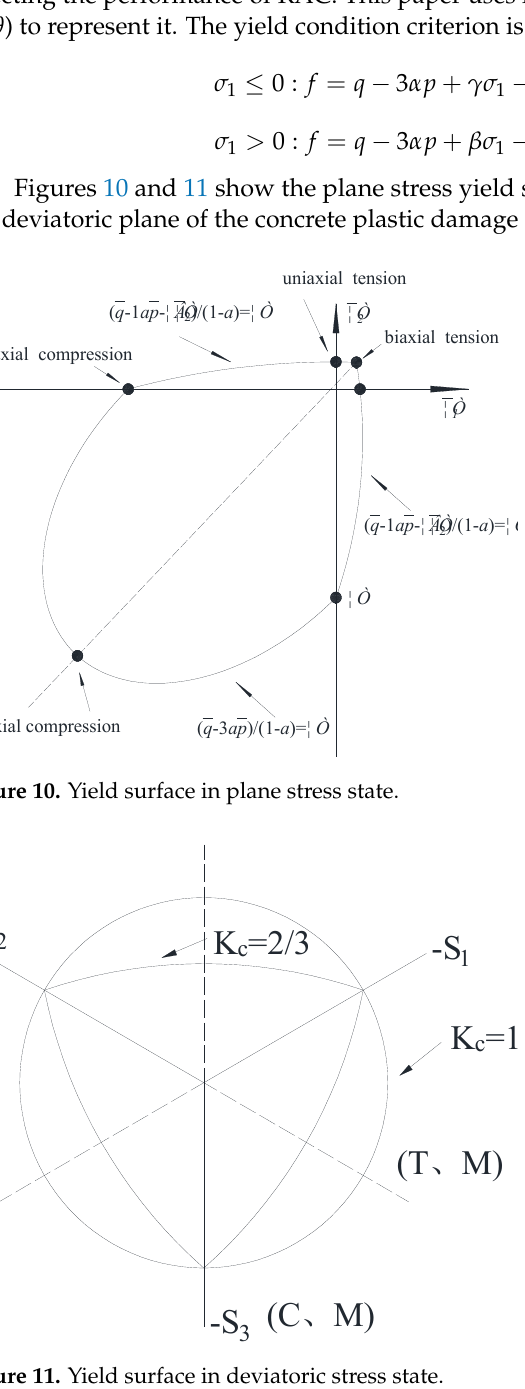
Figure 11. Yield surface in deviatoric stress state.